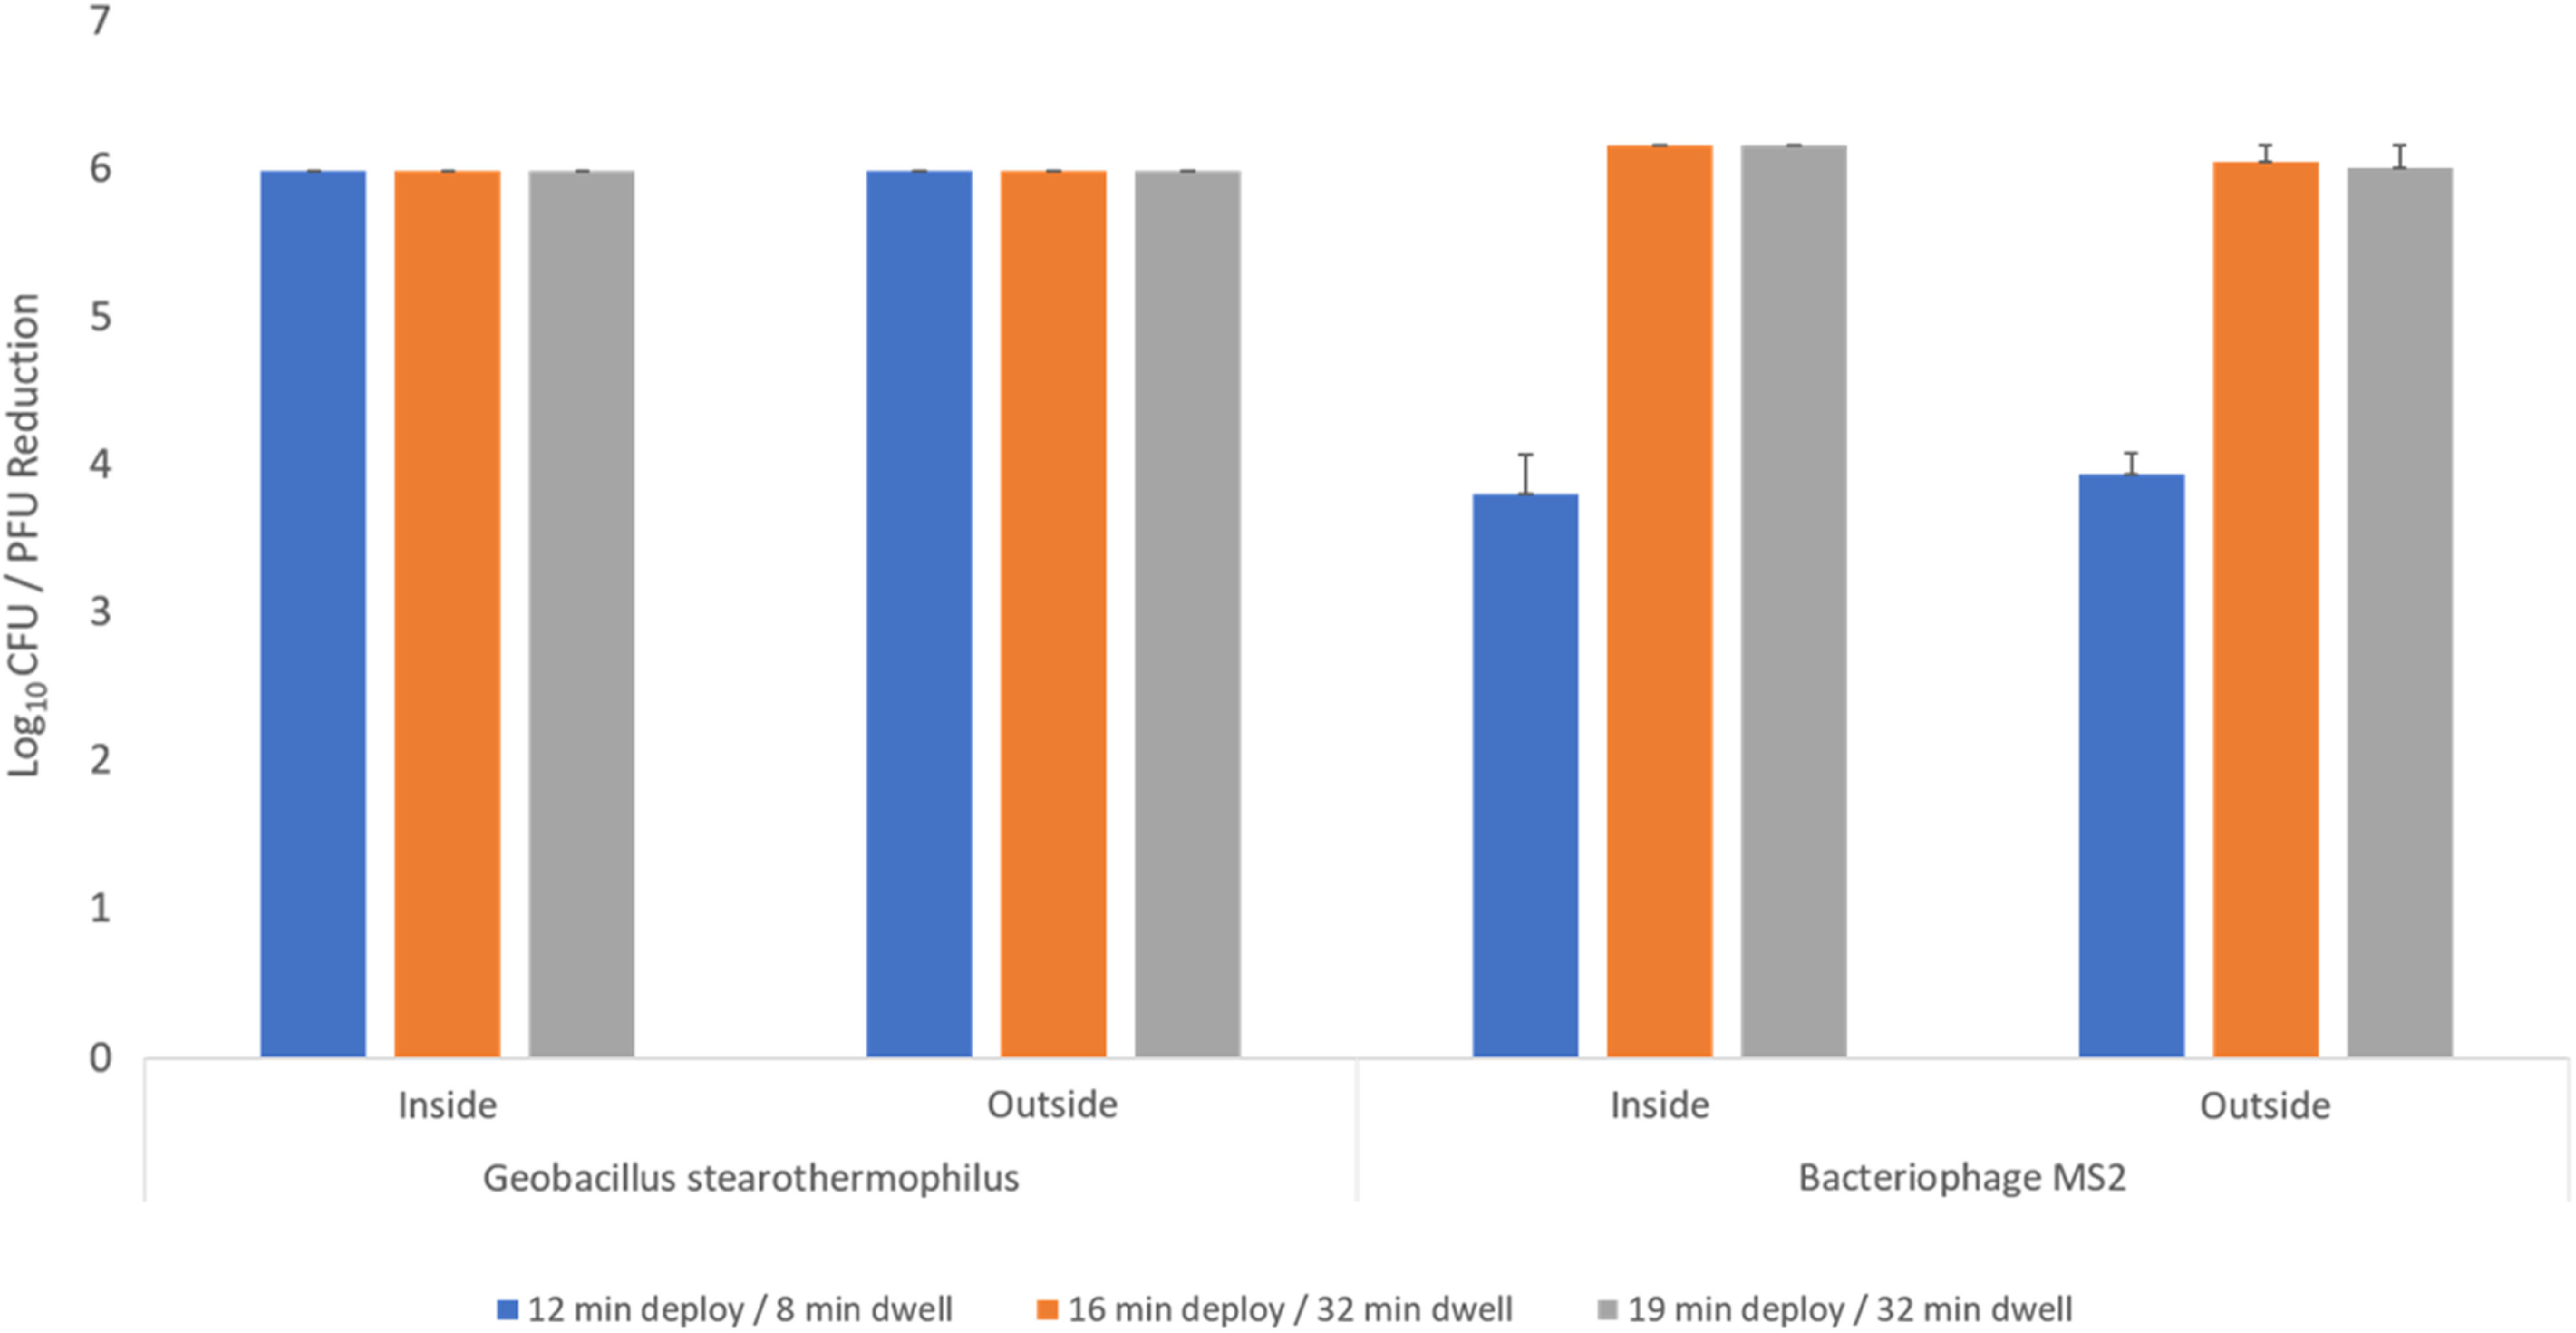
Efficacy of PAA HLDS for decontamination or disinfection of Geobacillus stearothermophilus spores and MS2. The respirator was exposed to 3 different cycles as in the figure and log10 reductions CFU/PFU studied. Error bars indicate standard error.